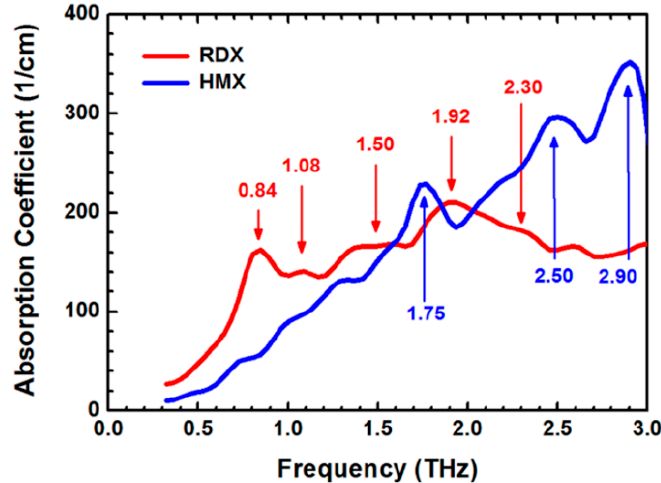
Figure 4. The absorption coefficient spectra of cyclotrimethylenetrinitramine (RDX) and HMX. Adapted from [75], with permission from © 2014 American Institute of Physics.